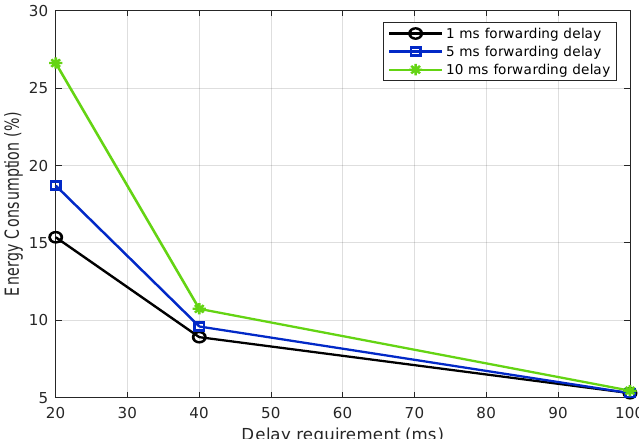
Figure 10. Energy consumption of a fog computing infrastructure under different service times of a fog node in the proposed GDAFC.